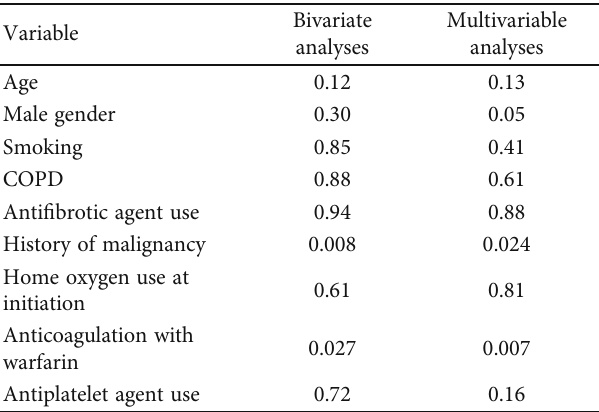
Table 3: Association of baseline variables with mortality at one year, on bivariate and multivariate analyses ( p values).